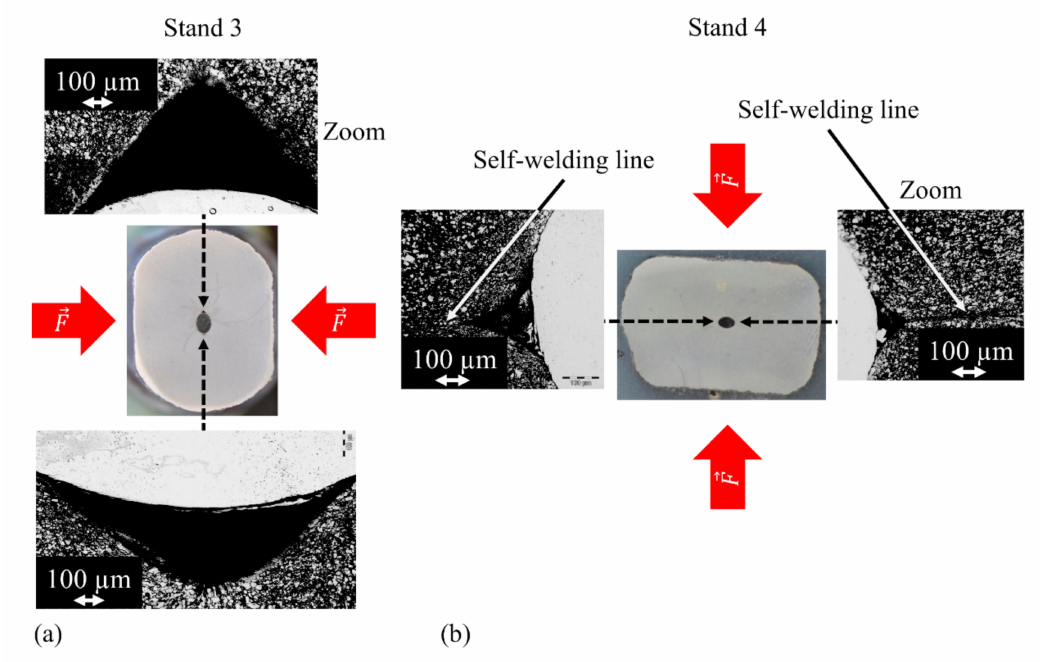
Figure 14. ( a ) Stainless-steel defect morphology after stand 3 and ( b ) stainless-steel defect morphology after the stand 4 exhibiting bonding